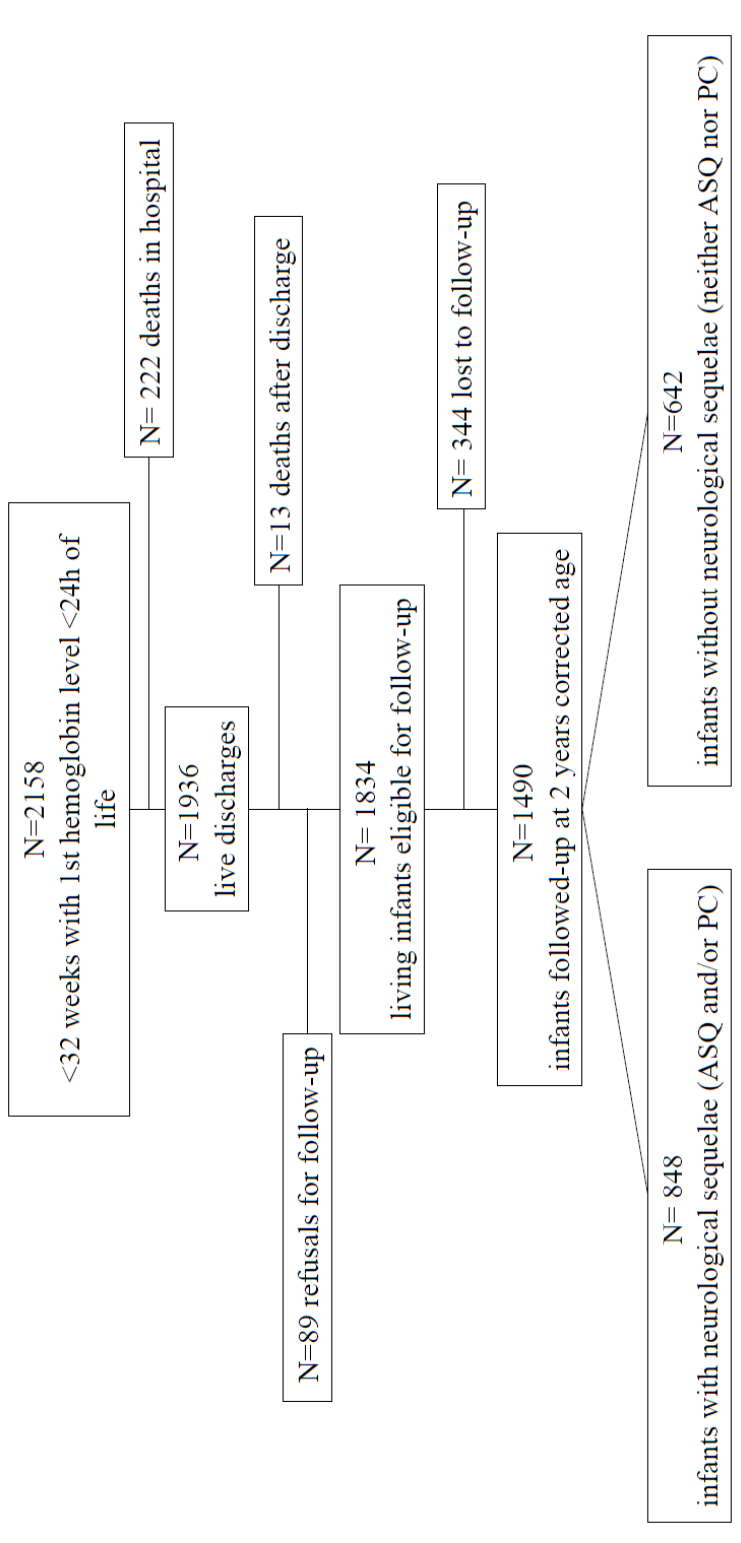
Figure 1. Study population’s flow chart.